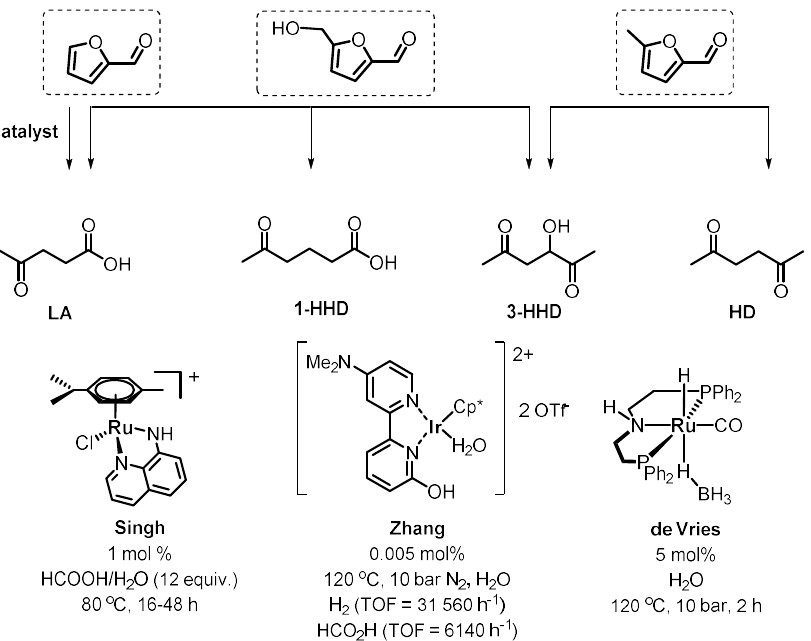
Figure 6. Ring opening reduction of furanic aldehydes with transition metal catalysts.